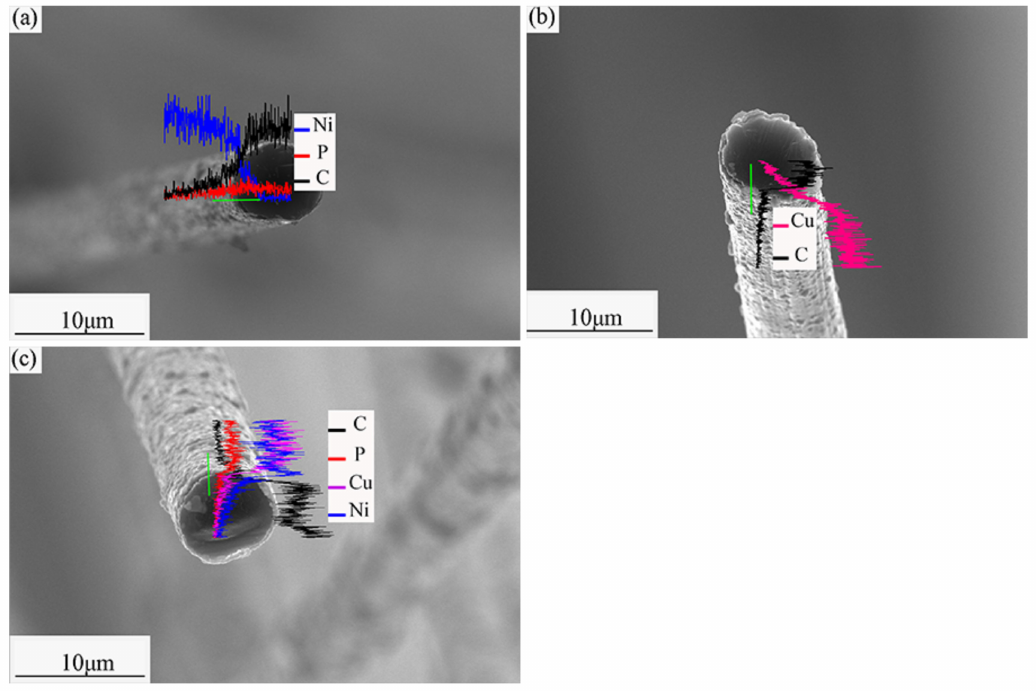
Figure 1. Scanning electron microscopy (SEM) images of the interface microstructures of the modified short carbon fibers (SCFs): ( a ) Ni-Cf; ( b ) Cu-Cf; and ( c )